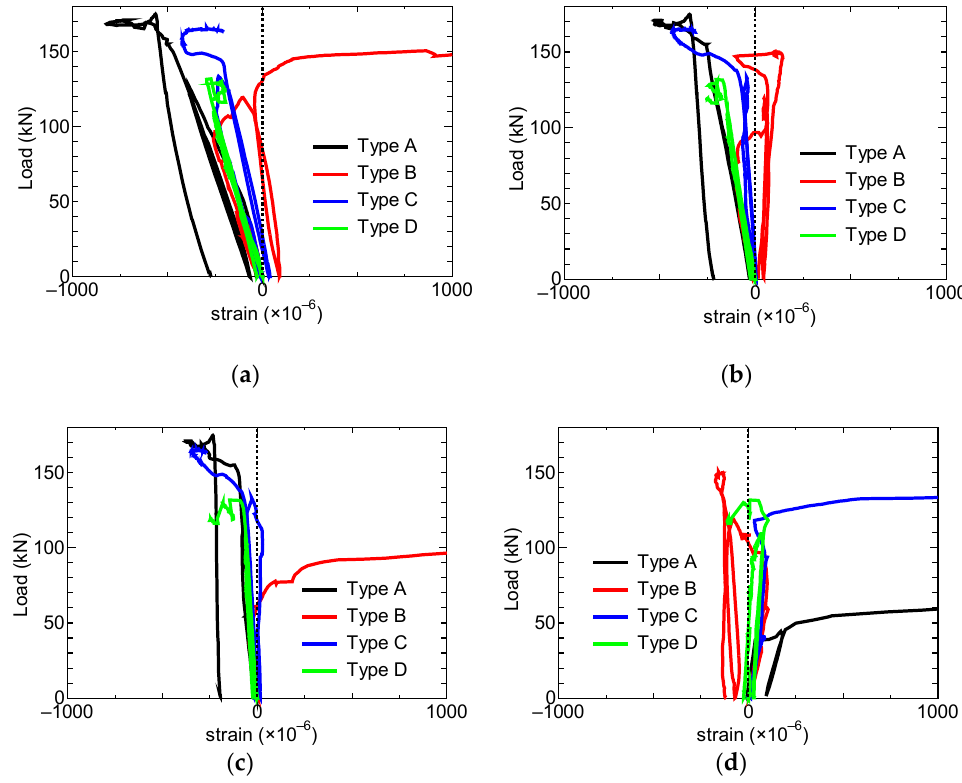
Figure 13. Relationship between applied load and strain of joint material at span center ( a ) C1; ( b ) C2; ( c ) C3; ( d ) C4 (locations of C1 to C4 in Figure 5d).